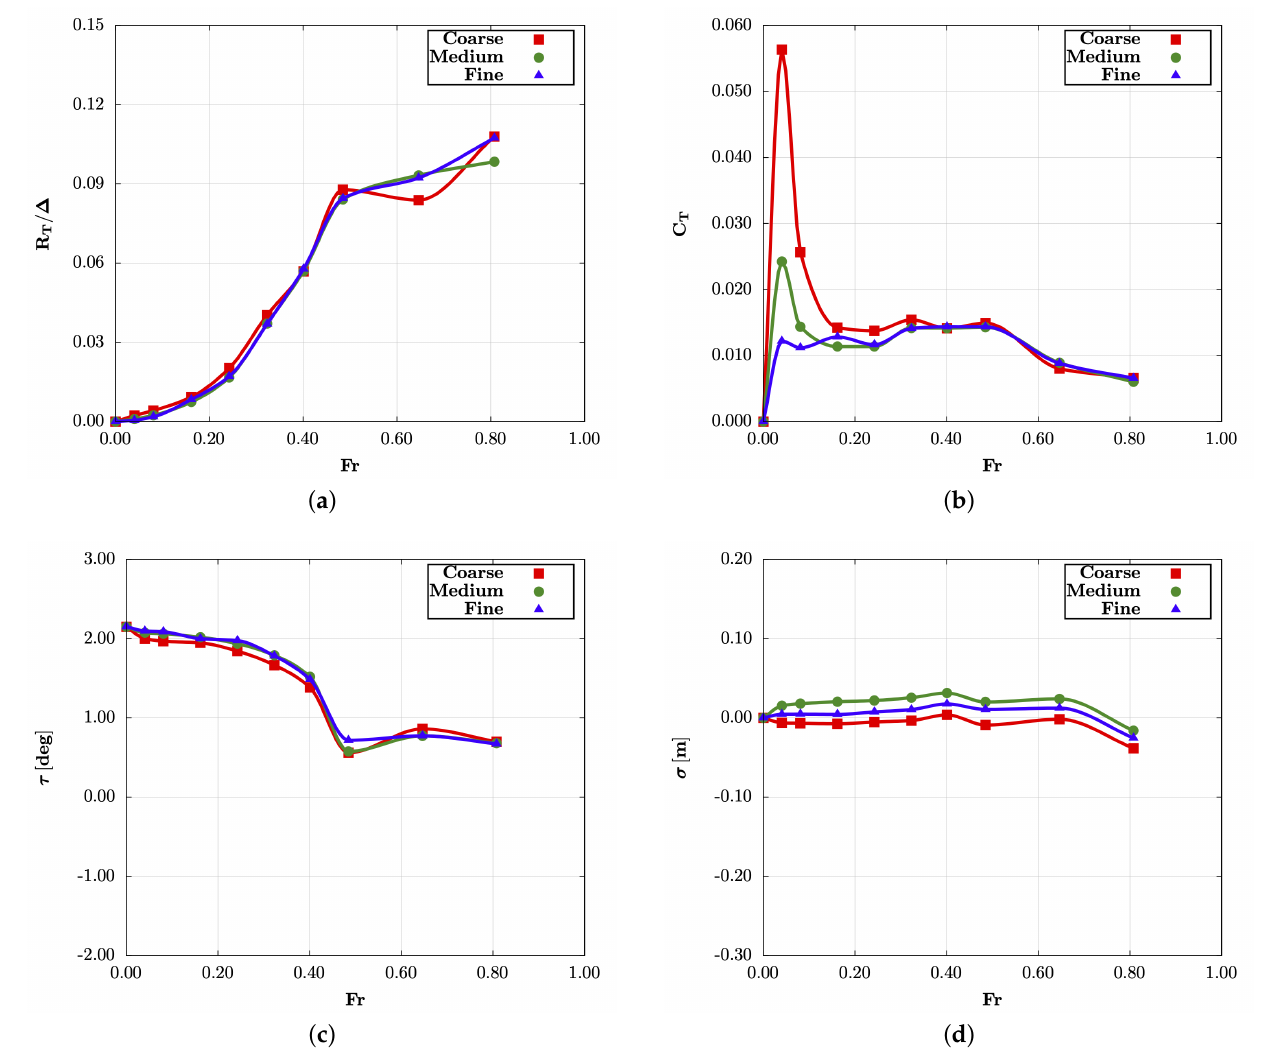
Figure 7. The effect of mesh refinement on the hydrodynamic performance; ( a ) Non-dimensionalized total resistance versus Fr , ( b ) total resistance coefficient versus Fr , ( c ) dynamic trim versus Fr , ( d ) dynamic sinkage versus Fr